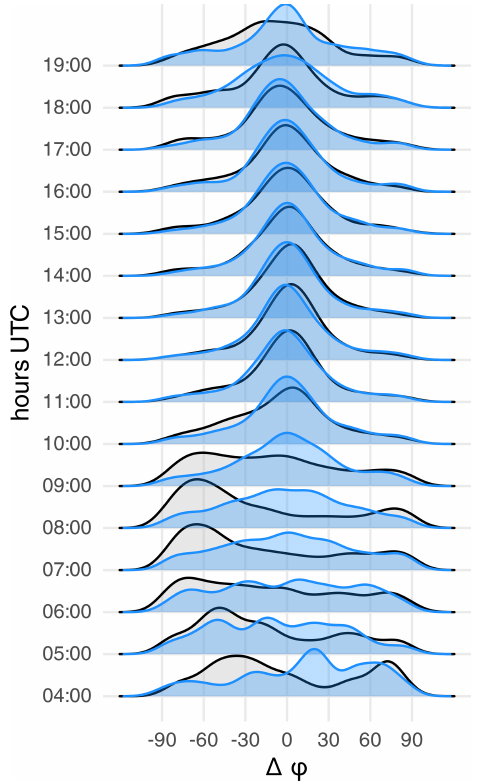
Figure 9. Distribution of orientations relative to the COSMO-REA2 mean wind throughout the day. COSMO-REA2 is shown in black, and RADOLAN is shown in blue. Only complete, non-rainy day- time cases with ρ( RADOLAN ) > 0 . 1 are included.